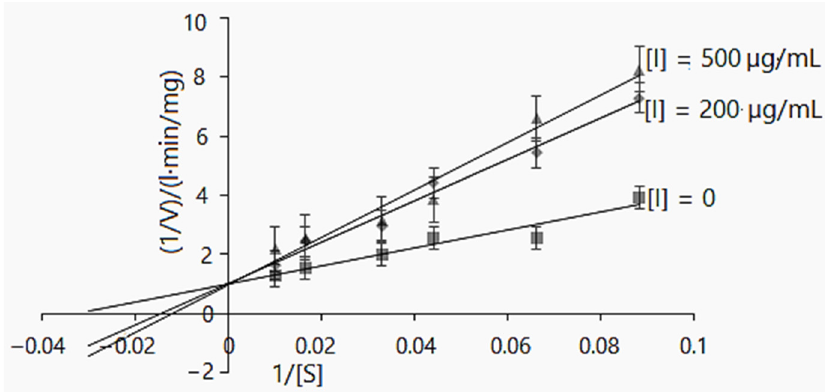
Figure 3. Lineweaver–Burk inhibition plot of α -glucosidase enzyme activity using D. caucasica tuber extract and different concentrations of p NPG (0, 0.004, 0.005, 0.008, 0.01, 0.02 and 0.33 mM). The signs and symbols on the graphic refers: squares: none inhibitor, rhombuses: 200 µg/mL of tubers extract concentration; triangles: 500 µg/mL of tubers extract concentration, [I]: inhibitor/extract; [S]: substrate. The values are the means ± SD ( n = 3).